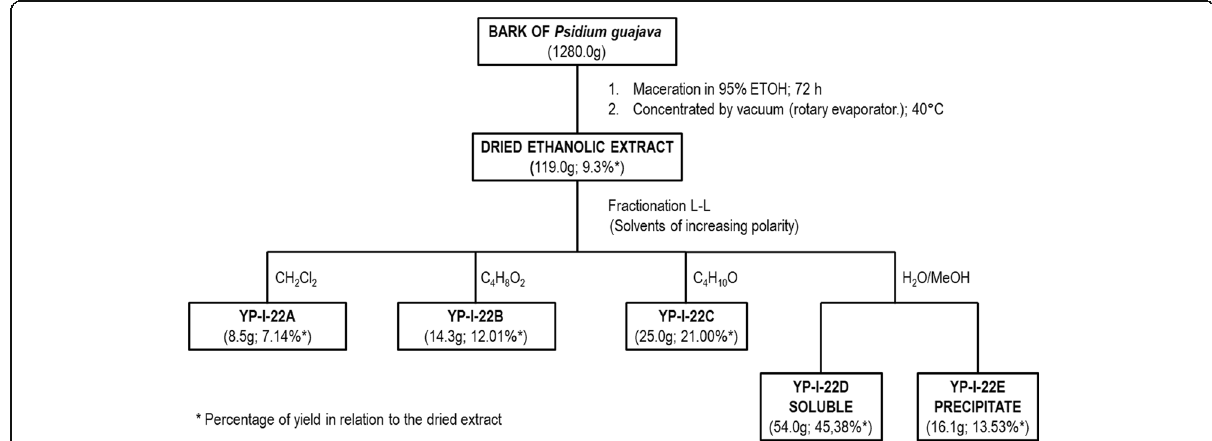
Fig. 1 Fractionation of the ethanolic extract of P. guajava bark. Open column chromatographic fractionation of the active fraction Pg -YP-I-22C obtained from the total ethanol extract of P. guajava bark using Sephadex G10 as a stationary